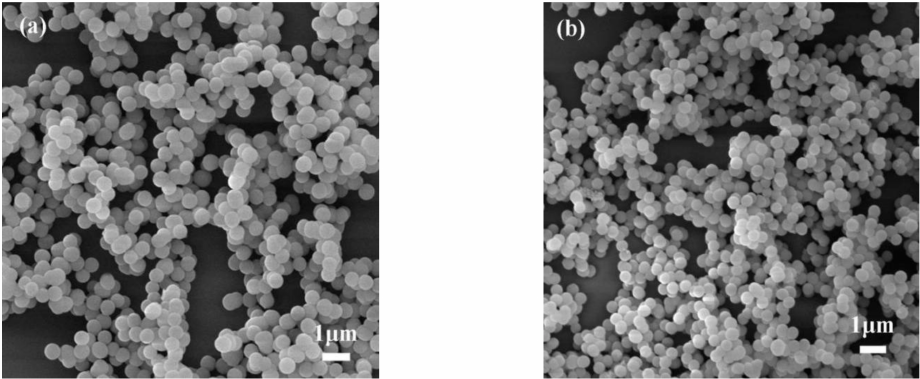
Figure 2. Micrographs showing morphologies of the Al 2 O 3 precursor ( a ) and calcined at 1000 ◦ C ( b ).